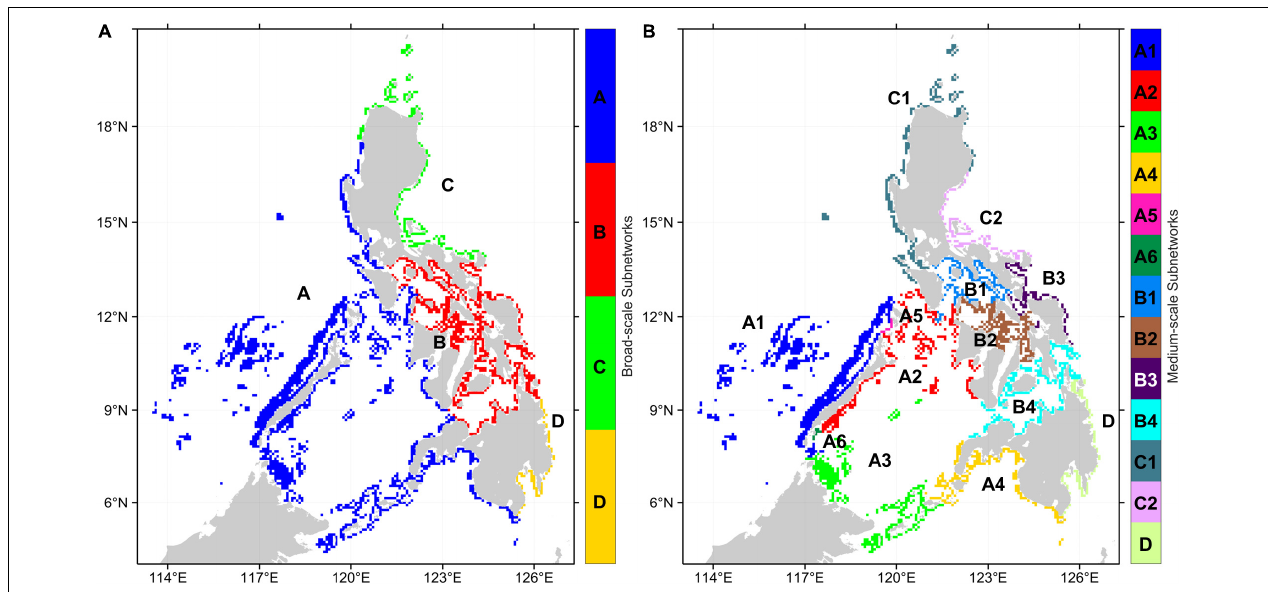
FIGURE 5 | Regional subnetworks based on the multiplex partitioning of the three organism networks. (A) Broad-scale subnetworks were partitioned with a resolution parameter of 0.0004. (B) Medium-scale subnetworks were partitioned with a resolution parameter of 0.004.